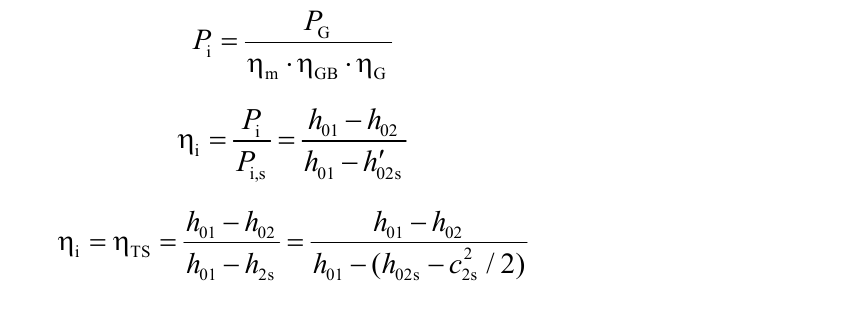
Table 3. Major assumptions for the thermodynamic